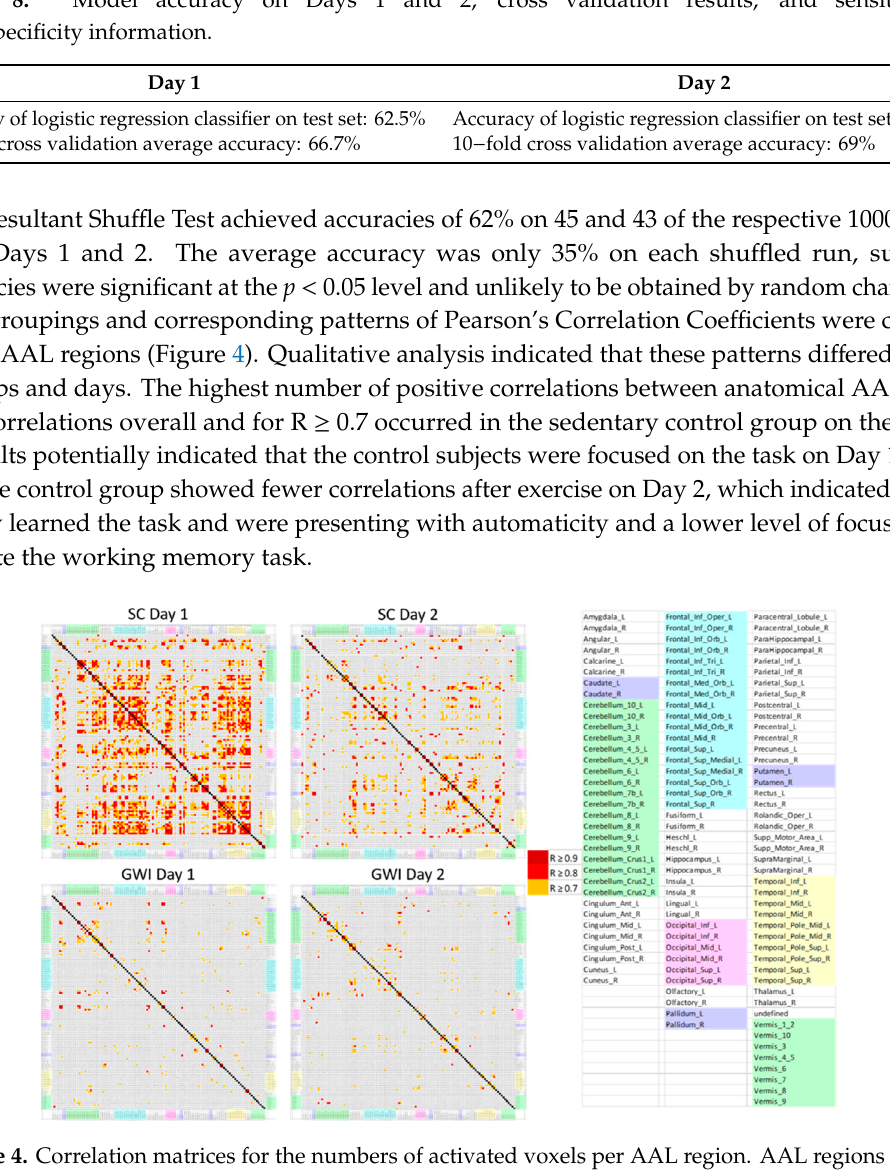
Figure 4. Correlation matrices for the numbers of activated voxels per AAL region. AAL regions were arranged in alphabetical order on the x − and y − axes. The number of significant Pearson correlations (R > 0.7 in orange, R > 0.8 in red, R > 0.9 in dark red) was higher for the SC group on Day 1 and decreased on Day 2. However, GWI had few correlations between regions on either Day 1 or 2. There were no negative correlations (R < −